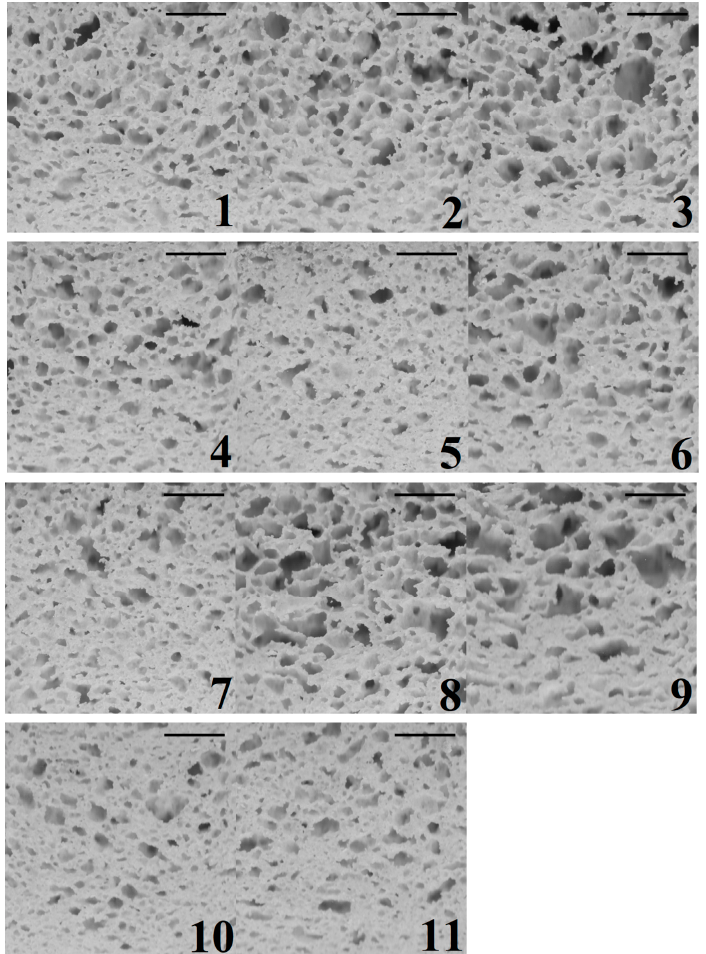
Figure 4. Crumb grain images of the 11 treatments of gluten-free bread produced by varying xanthan, guar, and HPMC hydrocolloids. Numbers correspond to the formulations shown in Table 1 (Scale bars = 1 cm).